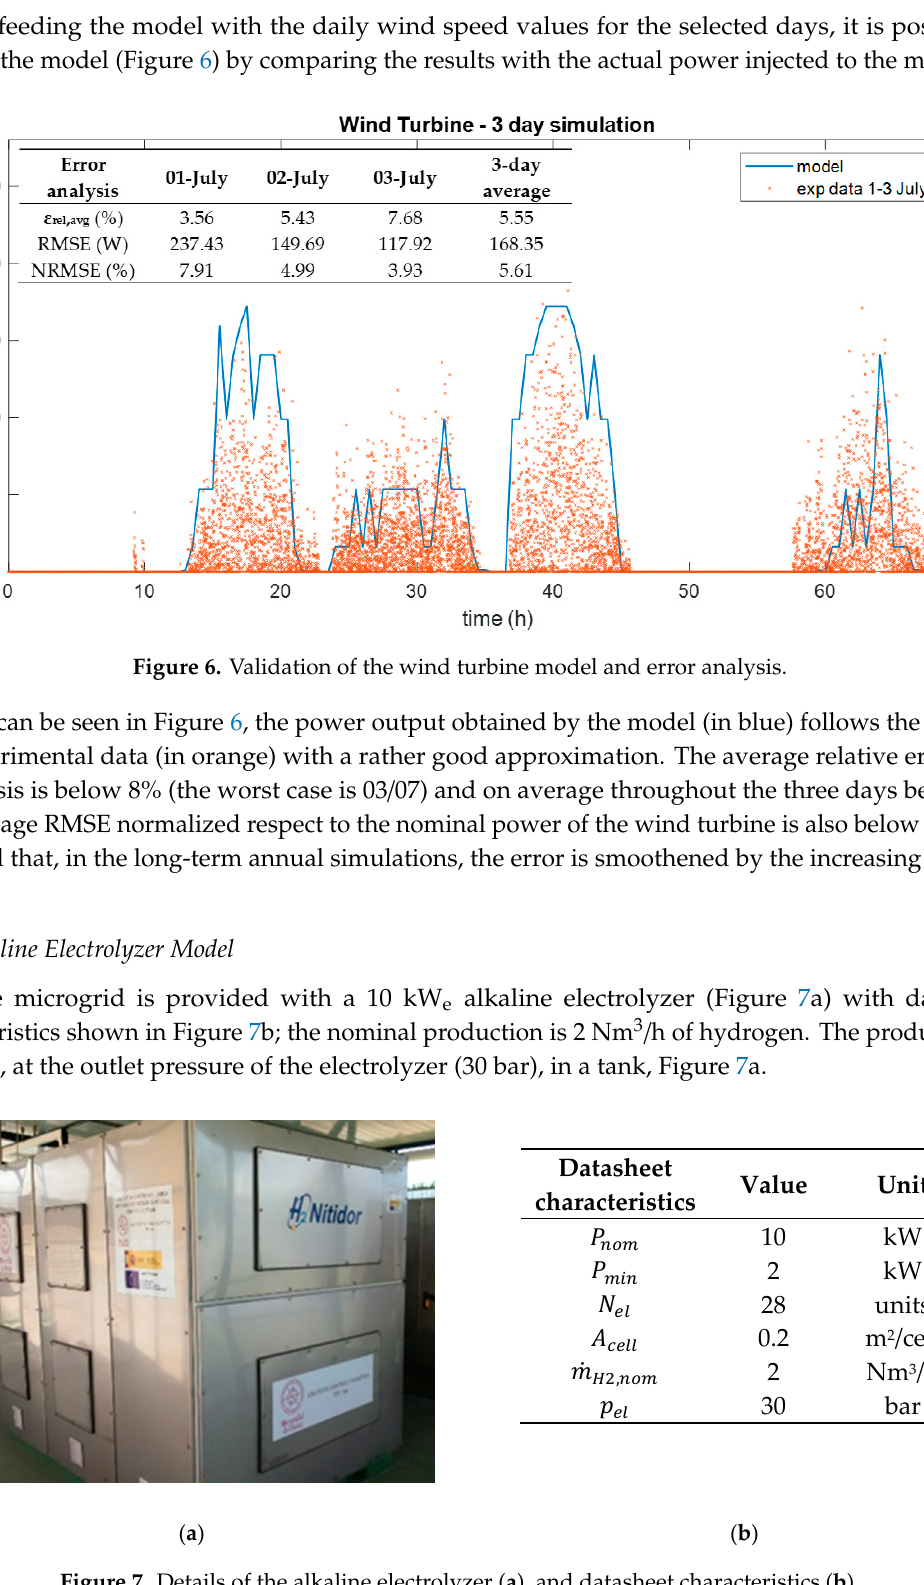
Figure 7. Details of the alkaline electrolyzer (a), and datasheet characteristics (b).